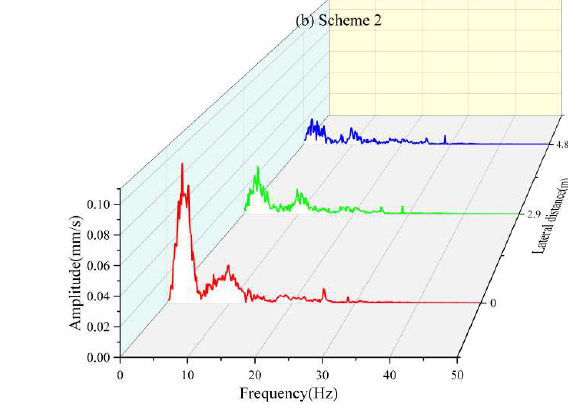
Figure 10. Vibration velocity level decay frequency–domain curve.